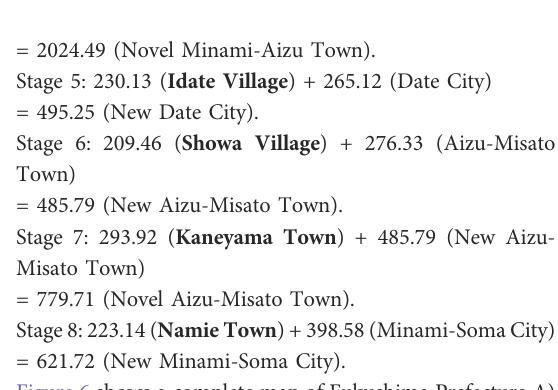
FIGURE 5 superimposed on the dots highlight the three prefectures in (C) . (C) Dependence of scaling exponent, q , on the consolidatory stage. Three prefectures (Hokkaido, Fukushima, and Nagano Prefectures) are selected from (B) , which are discriminated, respectively, with the red, green, and blue